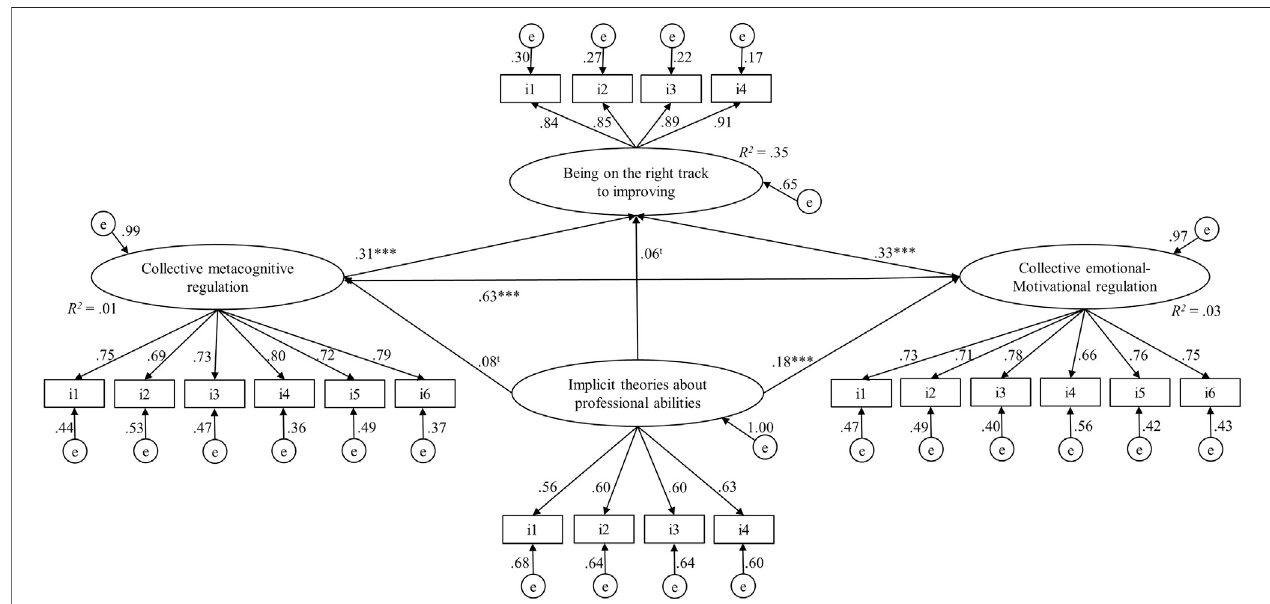
FIGURE 1 | Results of the structural equation model of teachers ’ implicit theories of professional abilities in school improvement (type (cid:1) COMPLEX; cluster (cid:1) school). χ 2 (164) (cid:1) 524.93, p < 0.001,scaling correction factor Yuan-Bentlercorrection (Mplus variant) (cid:1) 1.269: robust CFI (cid:1) .96, robust TLI (cid:1) 0.95; robust RMSEA [90%